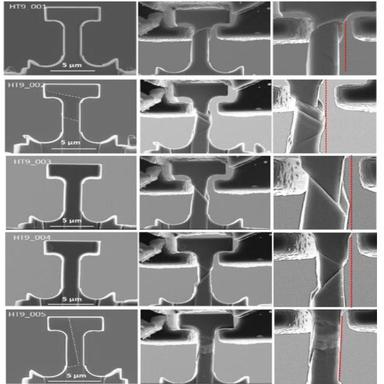
SEM micrographs before and after micro-tensile testing for HT9 matrix specimens (1–5) as labeled in 1. The identified grain boundaries in HT9_002 and HT9_005 were marked with white dashed lines. The vertical dash red lines at the right side of the SEM image of each specimen help to visualize the shape of the deformed specimens. All specimens except for HT9_005 were highly sheared.